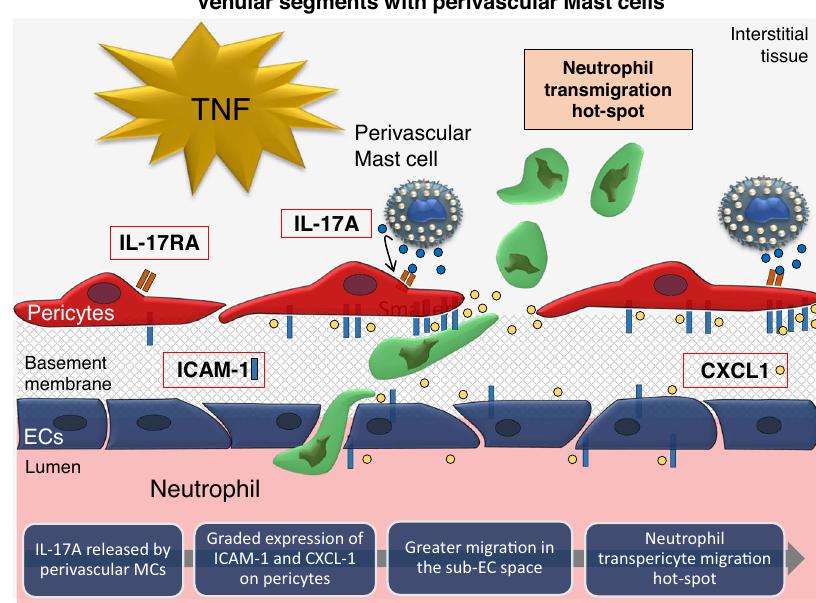
Fig.7|AModelfortheroleofperivascularmastcellsinguidingneutrophilsout ofthepericytelayerofbloodvessels. Uponacutein fl ammation,perivascularMCs release the cytokine IL-17A that promotes localised enrichment of intercellular adhesion molecule 1 (ICAM-1) and chemokine CXCL1 on nearby pericytes from